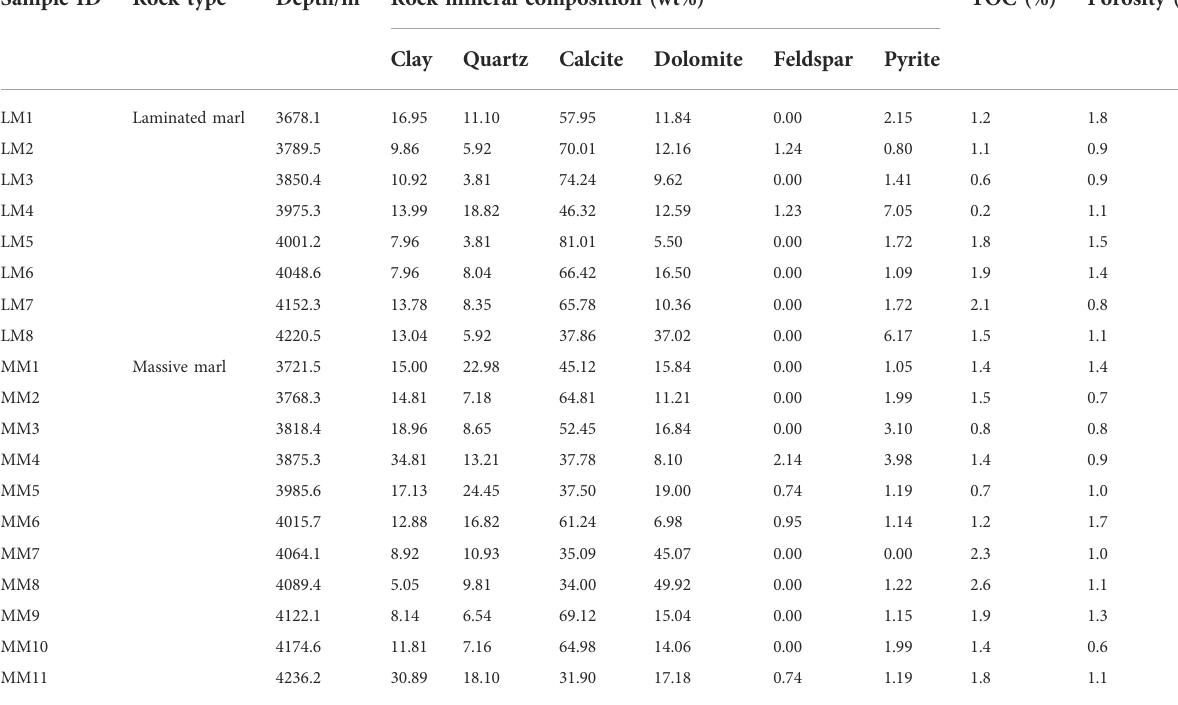
TABLE 1 Mineral composition, total organic carbon, and porosity of the samples from well ST1. Sample